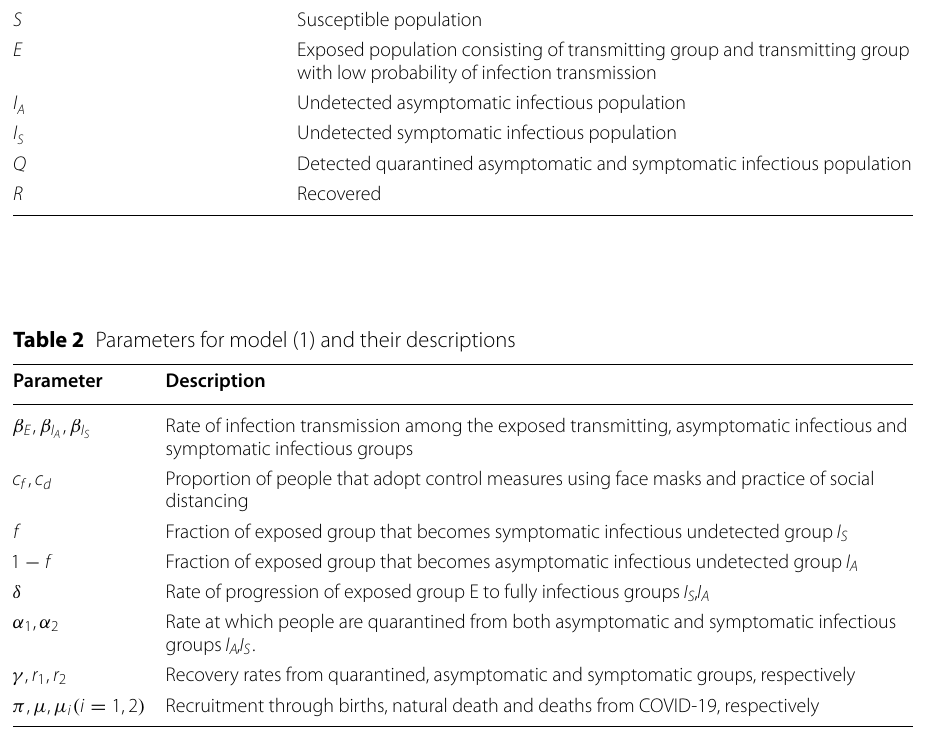
Table 1 Description of the state variables for model (1) State variable